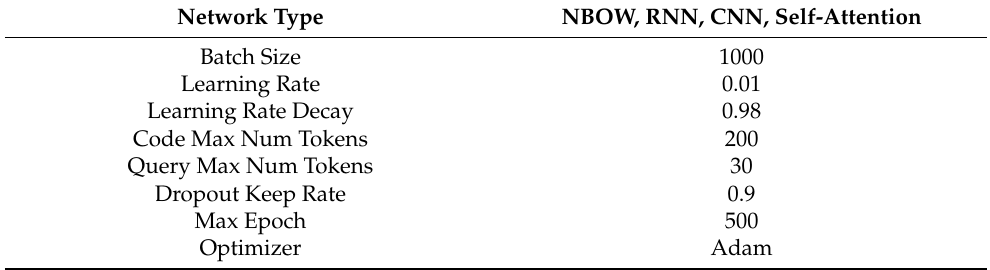
Table 3. Tracing network